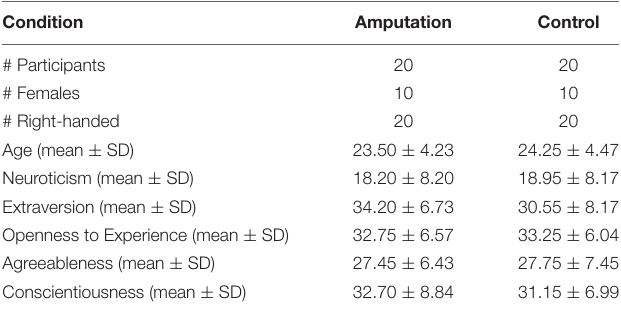
TABLE 1 | Demographic details of the participants. Condition